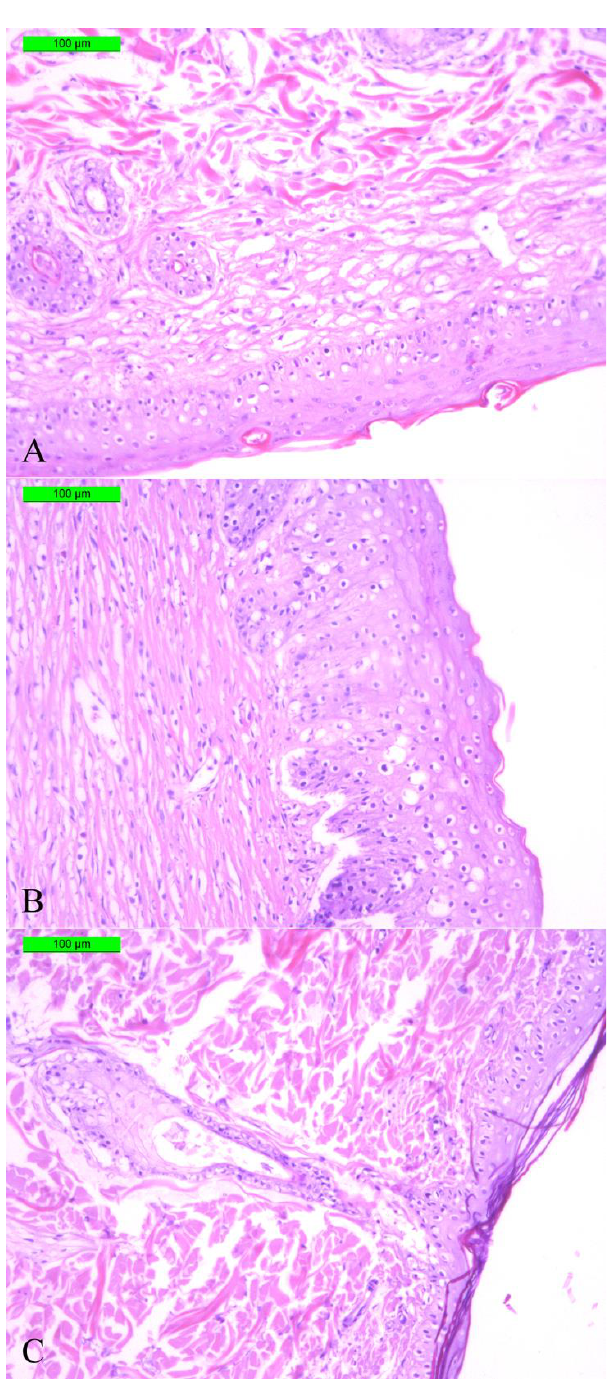
Figure 13. Optical microscopy images of skin tissue sections stained by Masson’s trichrome. ( A ) Control (40 days), ( B ) wound covered with SF scaffold (28 days), ( C ) wound covered with SF-MP scaffold (23 days). Scale bar 100 µm.